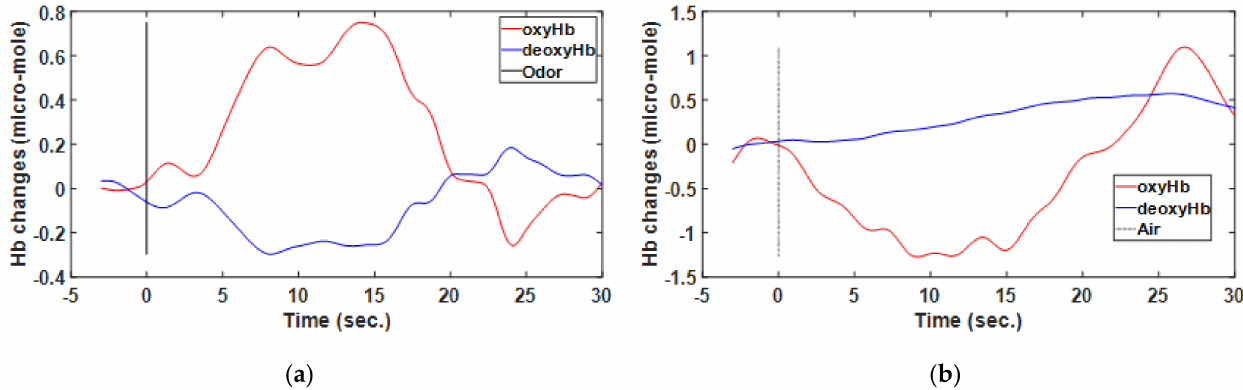
Figure 6. Hemodynamic response of one participant determined through functional near-infrared spectrometry. Subplots show the averaged results for the region of interest from among eight blocks wherein odor ( a ) and air ( b ) were used as individual